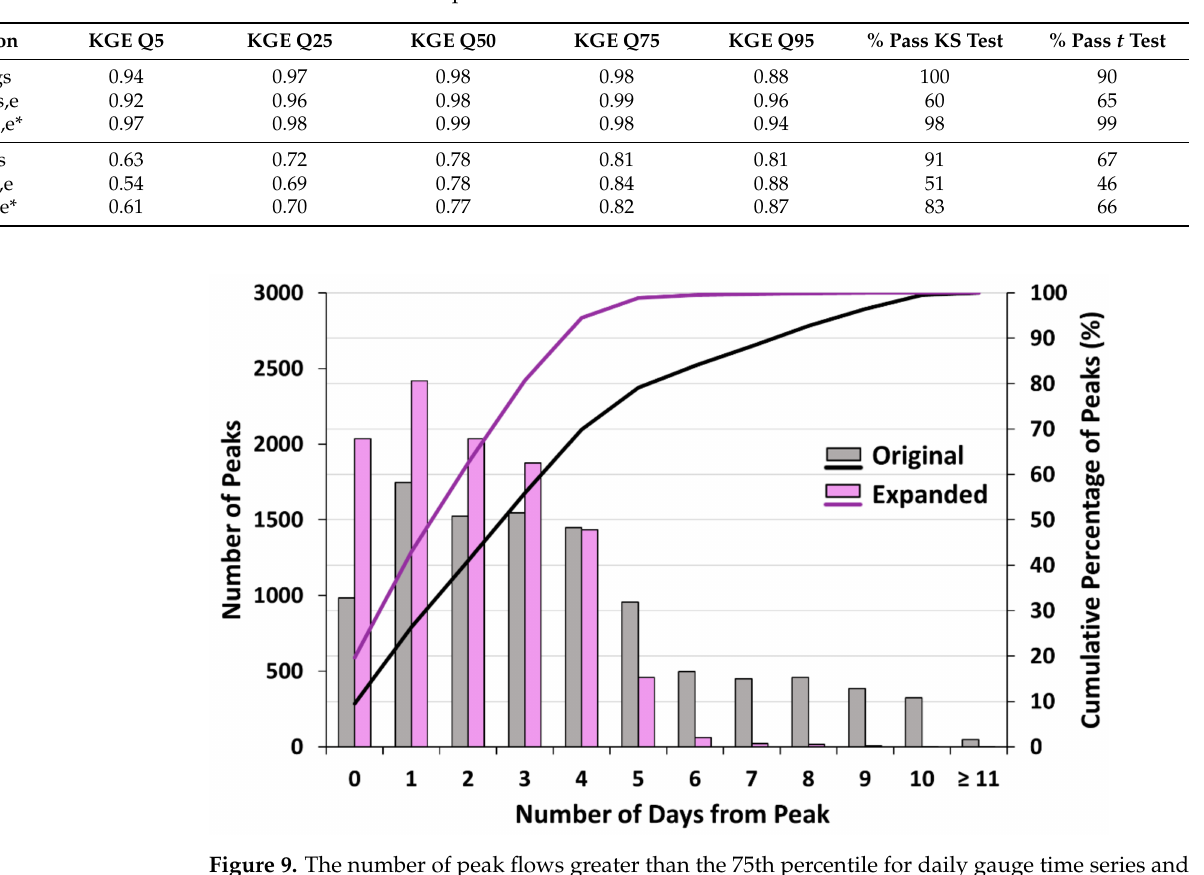
Table 1. KGE values for distribution quantiles compared between the daily distribution (Qg), and those of the SWOT simulated time series for the 167 gauges able to be expanded by additional SWOT measurements. Qgs and Qs distributions are derived from the original SWOT sampled time series, with Qs also including uncertainty. Qgs,e and Qs,e indicate expansion using the drainage area ratio, and Qgs,e* and Qs,e* indicate expansion with the gauge’s own discharges on added SWOT observation days for comparison purposes. The percentage of 167 that passed both the Kolmogorov-Smirnov (KS) test and Student t test for each distribution comparison are also listed.